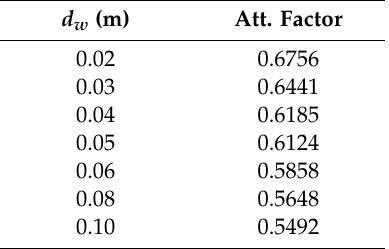
Table 2. Attenuation (Att.) Factors for varying water depth, Reference [31]. d w (m) Att.